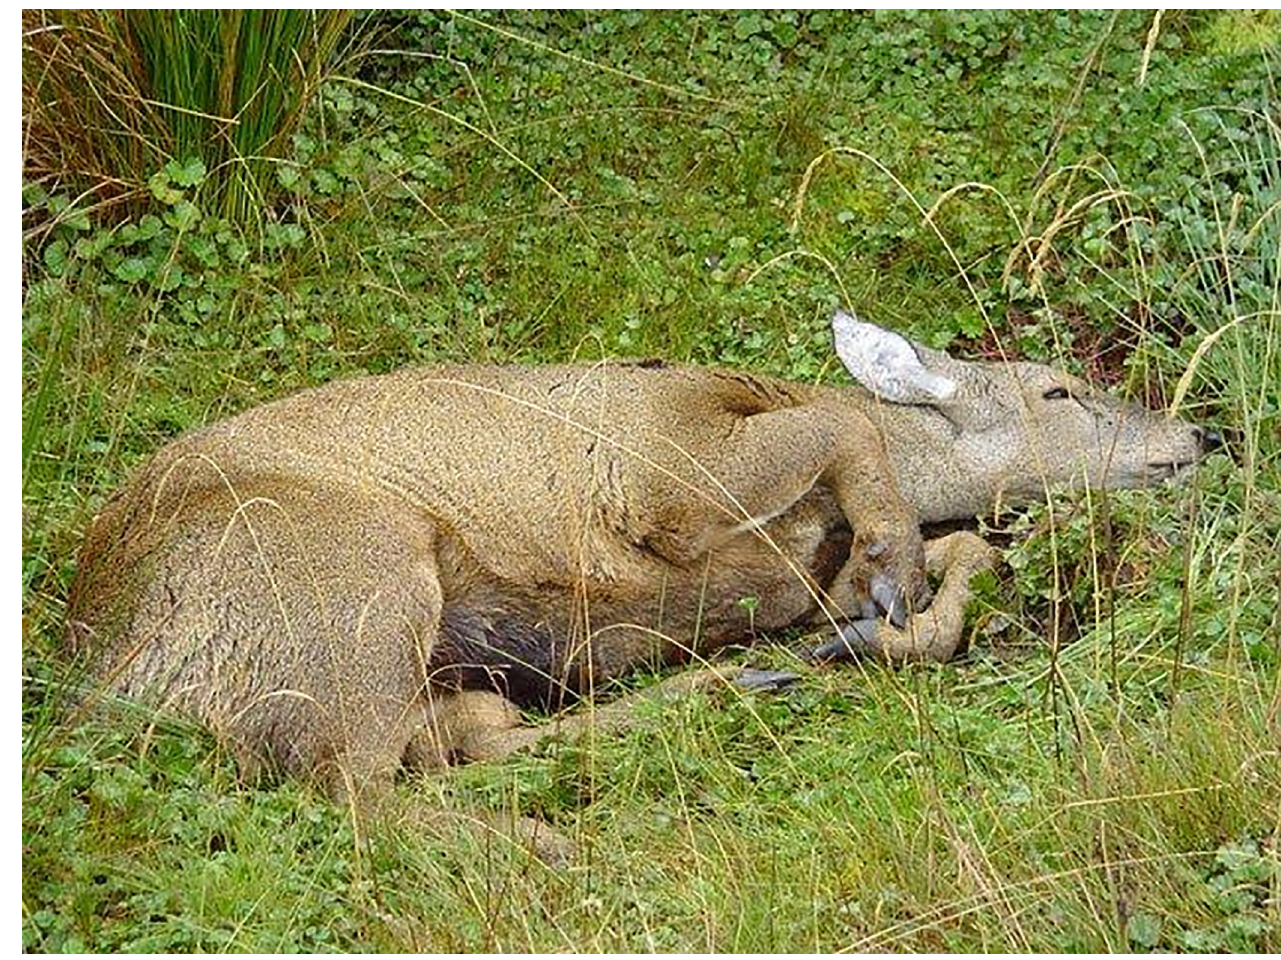
Fig 2. Adult female huemul (Case #1, Table 1), with swelling of right front leg and foot showing signs of pain and recumbency.